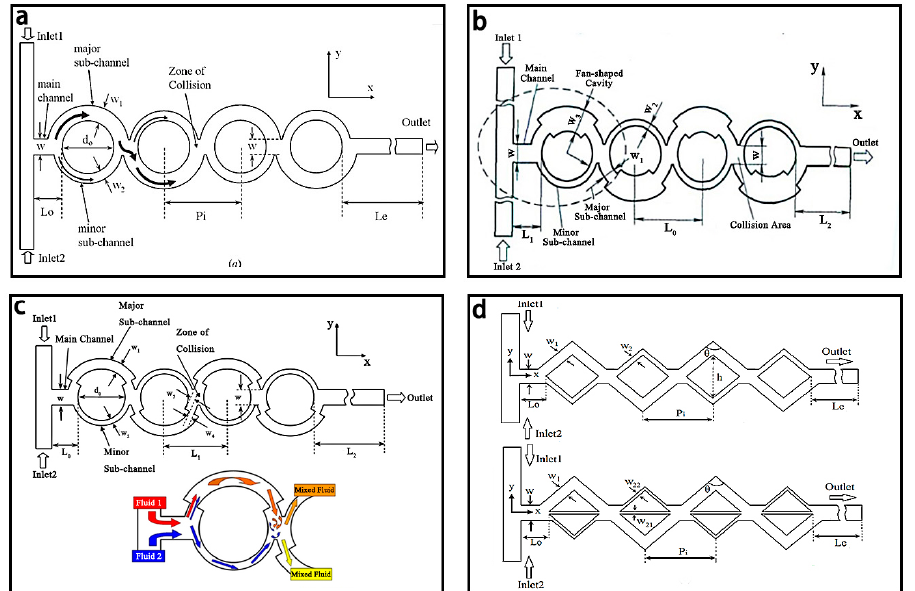
Figure 12. Schematic of the ( a ) unbalanced collision based micromixer; ( b ) unbalanced collision based micromixer with fan-shaped cavity in major sub-channel; ( c ) unbalanced collision based micromixer with stagger structure; ( d ) unbalanced collision based micromixers with two-split rhombus channel and with three-split rhombus channel. Reproduced with permission from [95,96,130,131].